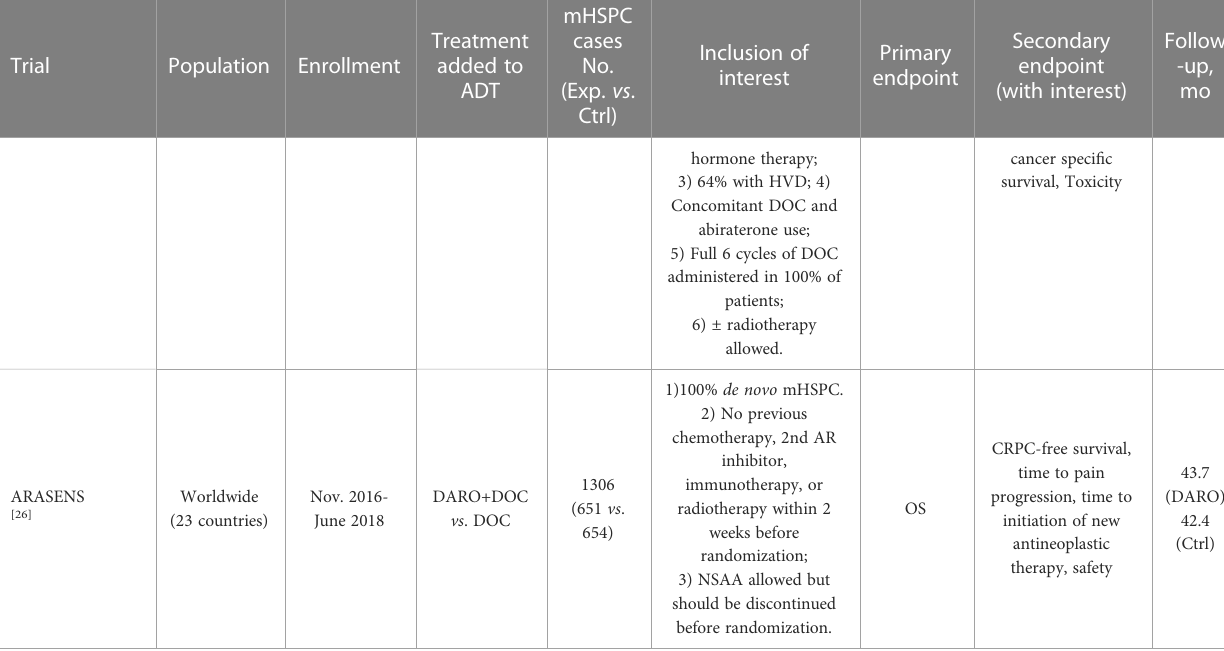
TABLE 2 Clinical trials or subgroups related to mHSPC ’ s triplet therapies.